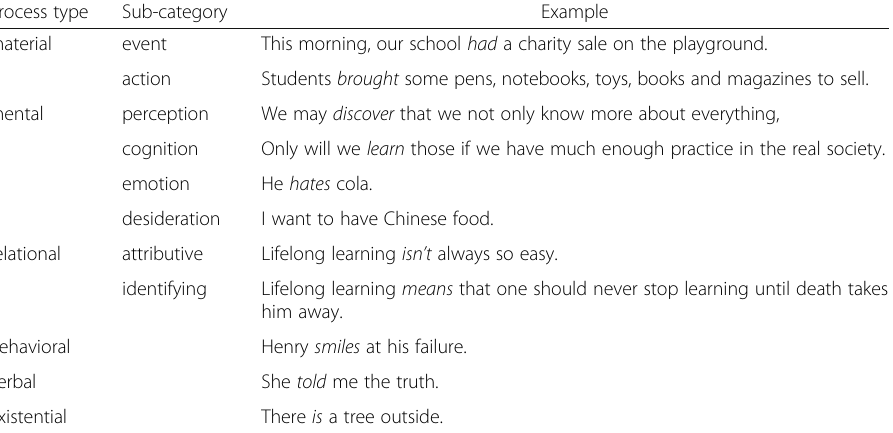
Table 2 Process types in English Process type Sub-category Example